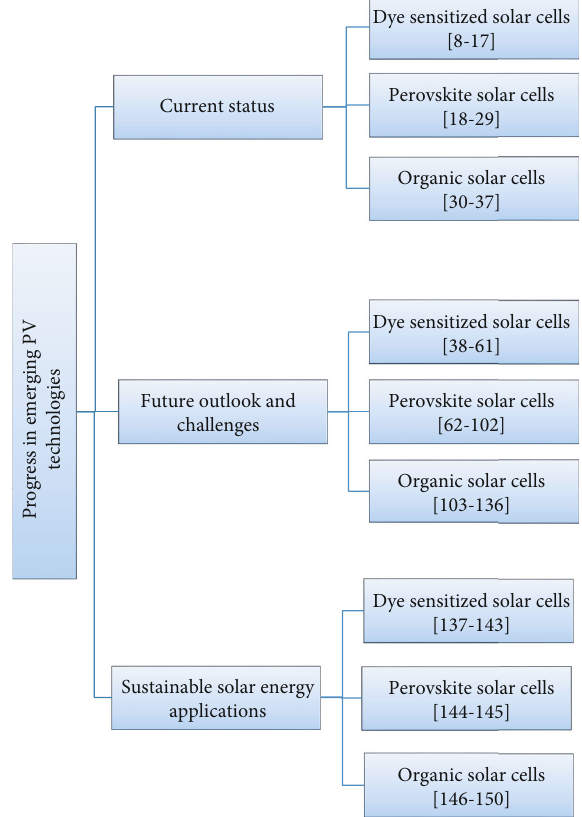
Figure 2: Outline of the main structure and literature citations of the